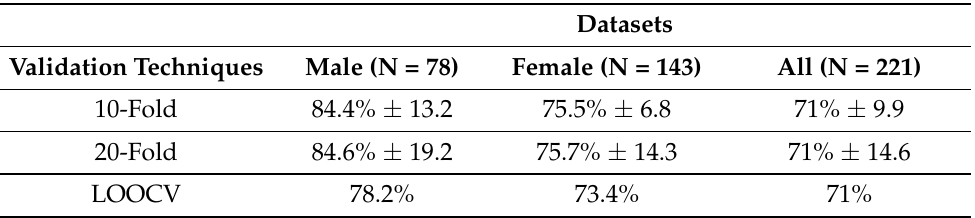
Table 5. Classification rates of the three models for each validation technique. Rates for K-fold techniques are presented ± standard